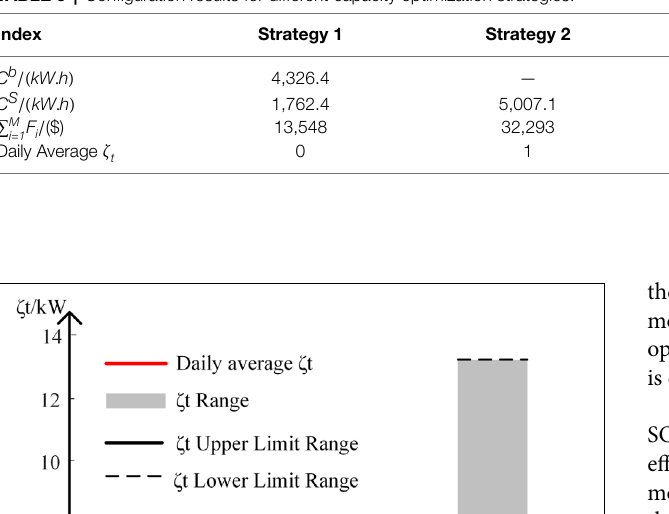
TABLE 5 | Configuration results for different capacity optimization strategies.